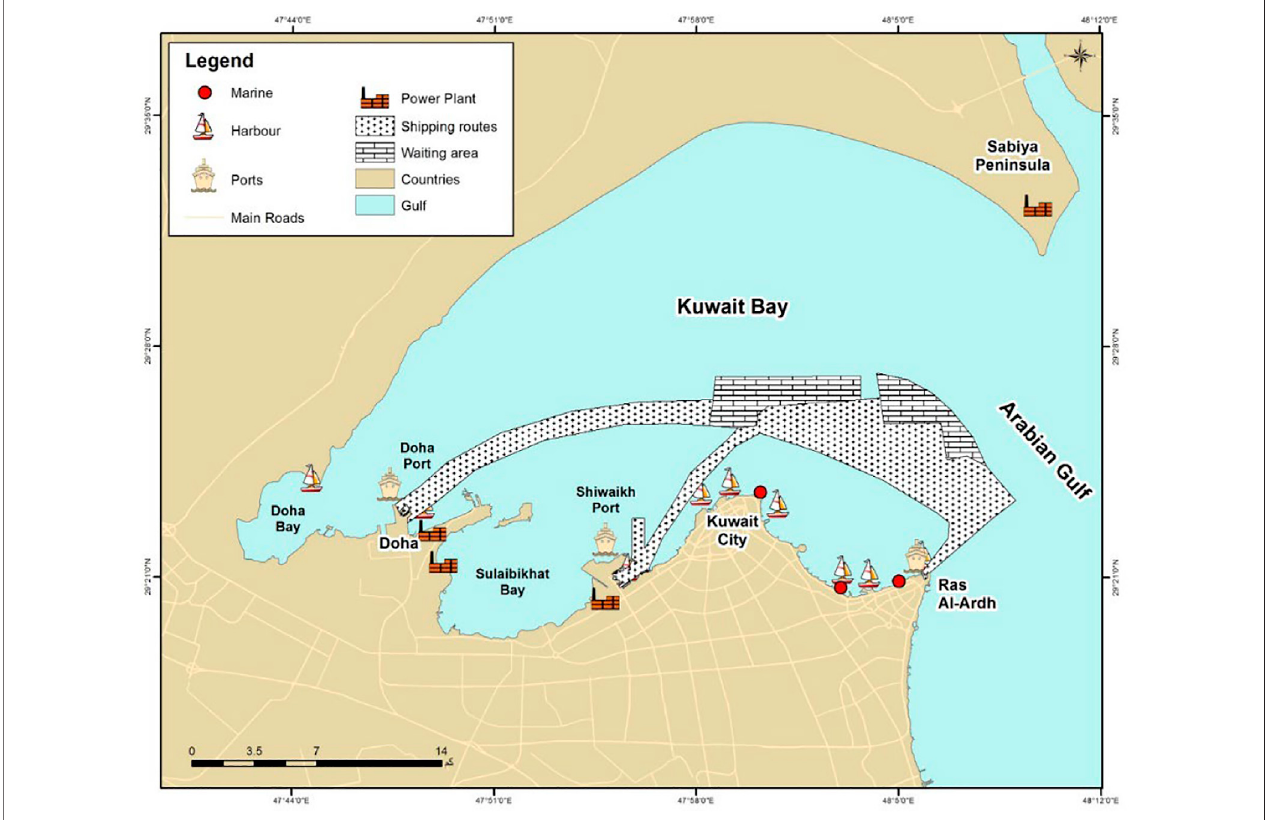
FIGURE 1 | Kuwait